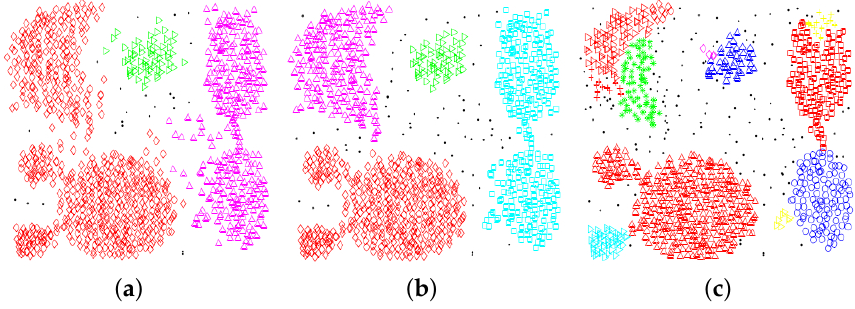
Figure 7. Influence of noise intensity on DBSCAN clustering effect. ( a ) noise = 100. ( b ) noise = 150. ( c ) noise =